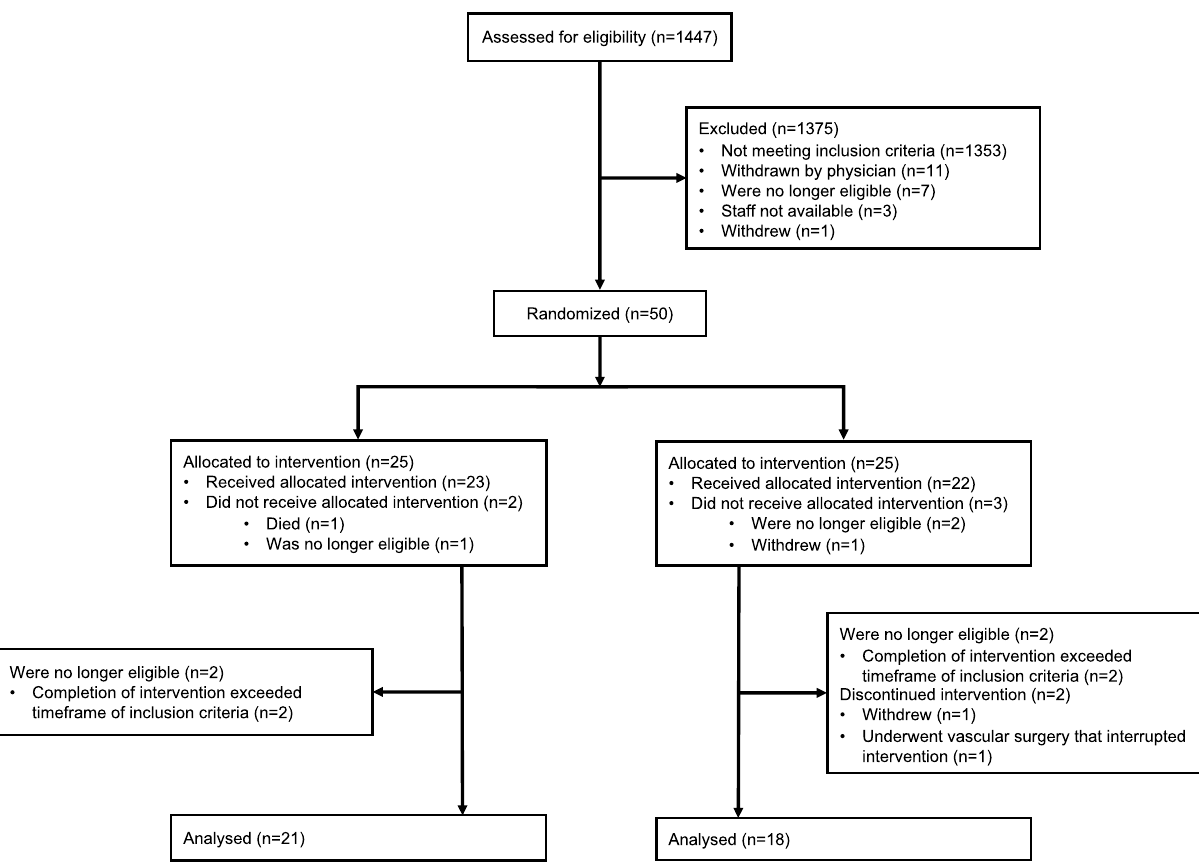
Figure 1. Patient screening and enrollment